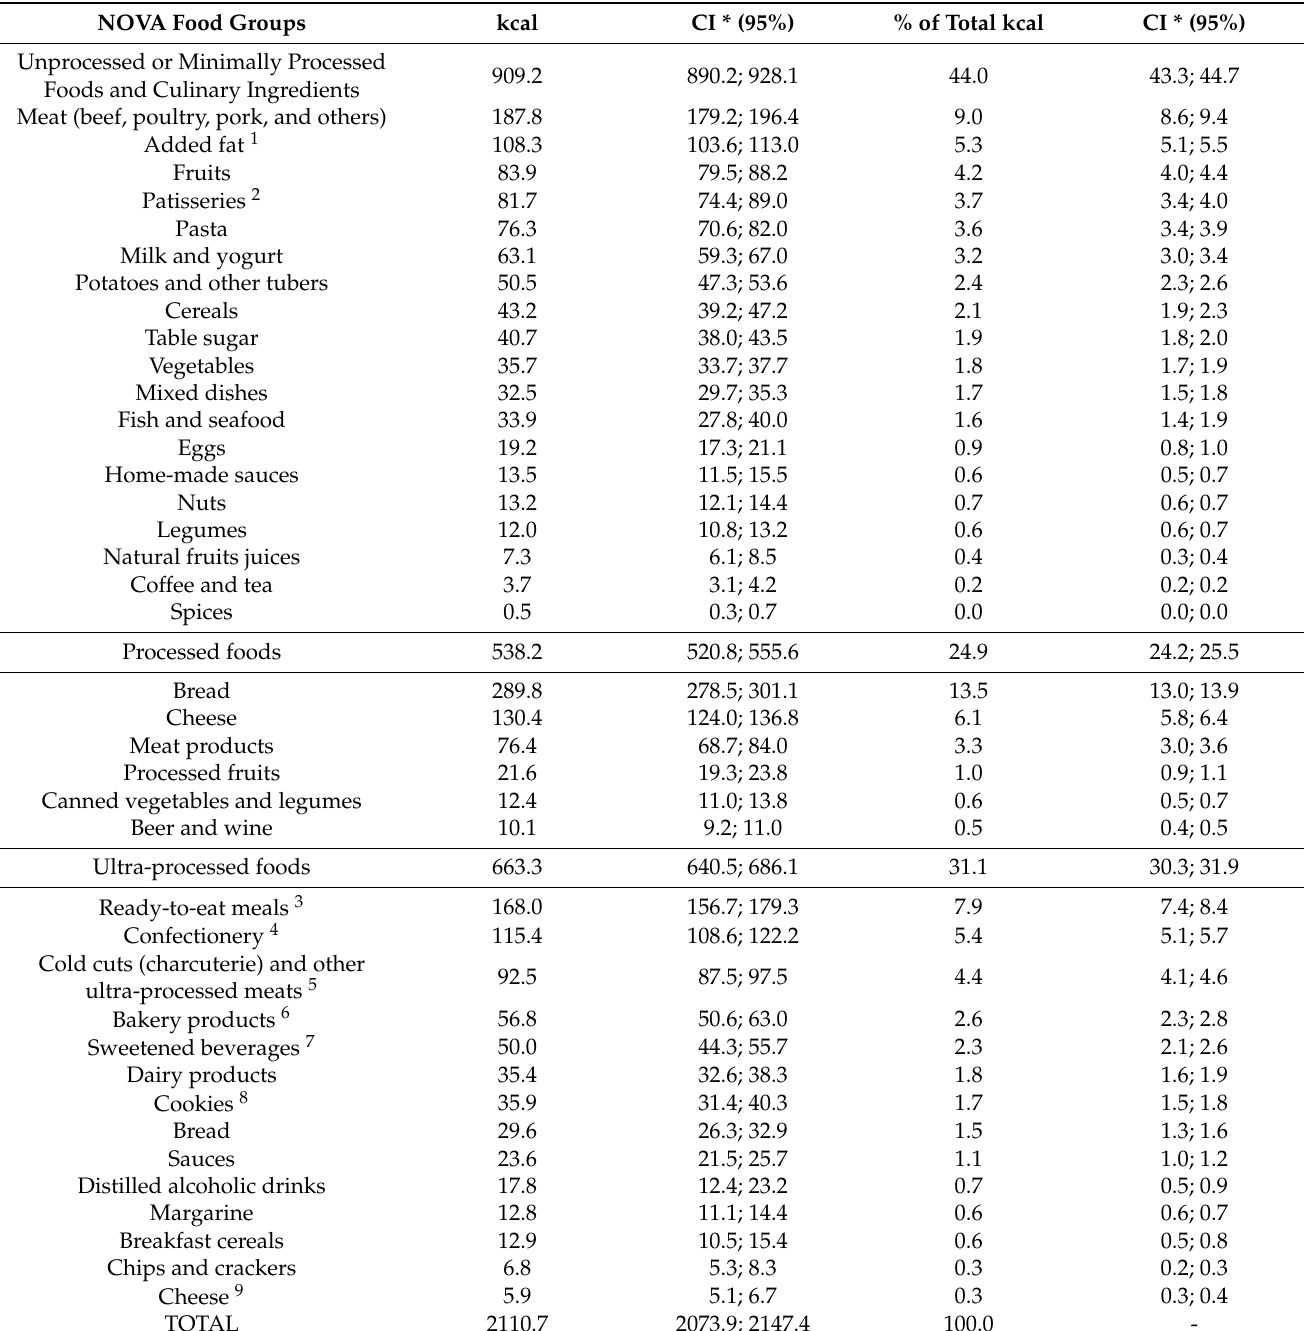
Table 2. Mean daily energy intake according to NOVA food groups. French population aged ≥ 18 years. É tude Nationale Nutrition Sant é (ENNS) 2006 ( n =